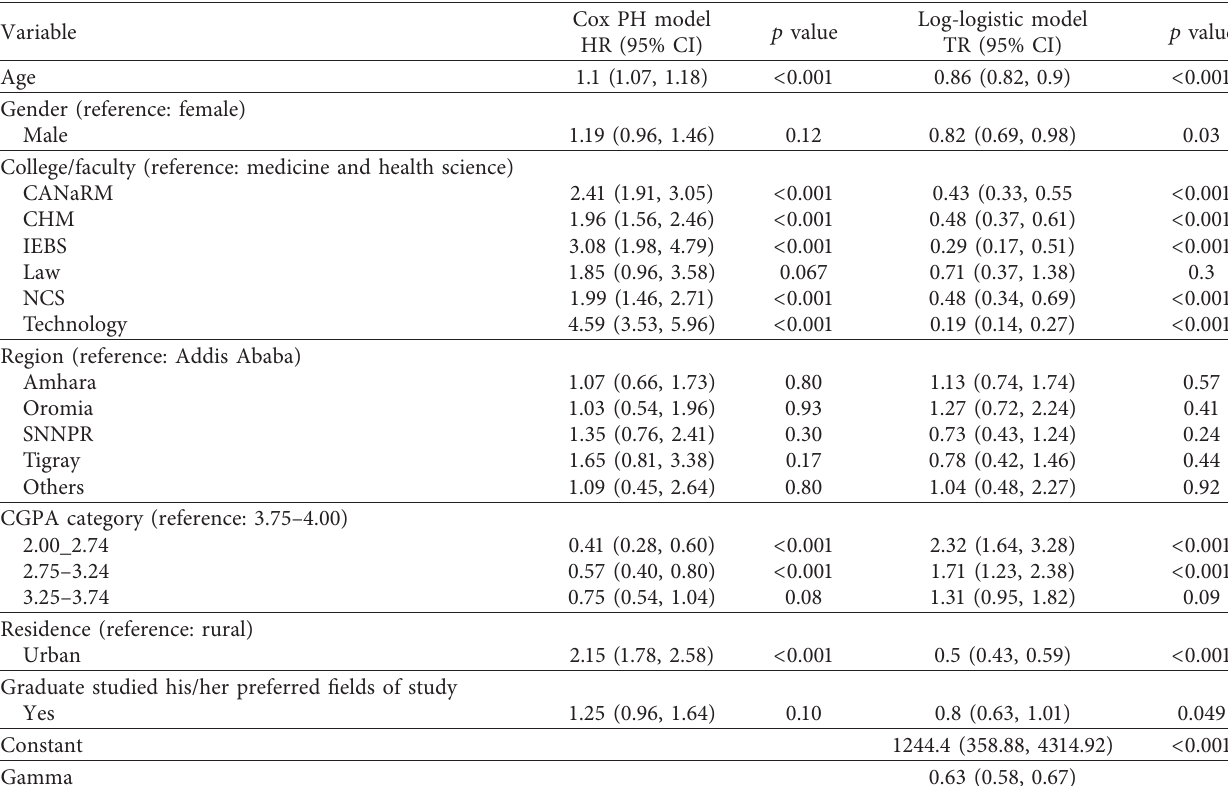
Table 2: Analysis of associated factors of unemployment time based on Cox PH and log-logistical AFT models.